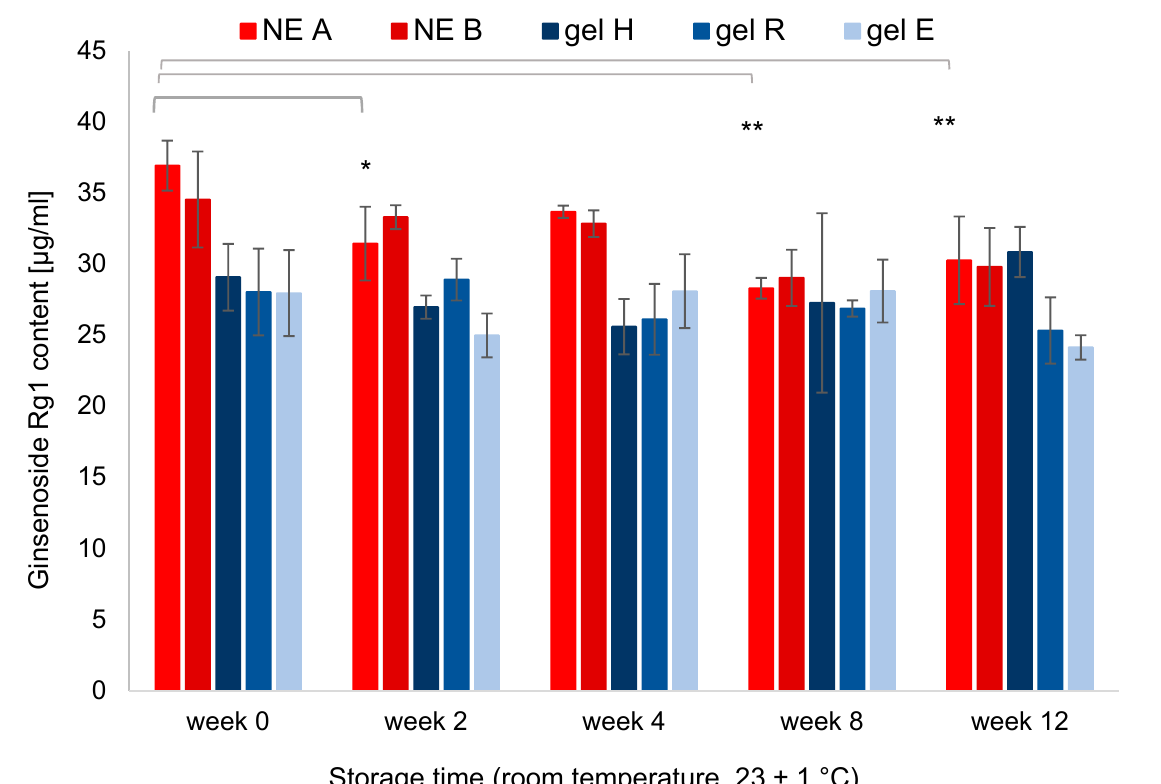
Figure 8. Rg1 content ( µ g/mL) of NEs and hydrogels with KRG extract after production and during storage at room temperature over twelve weeks. Values are means of n = 3 formulations ± SD. Statistical differences to the initial Rg1 content for each formulation are marked with asterisks (* p < 0.05, ** p < 0.01).